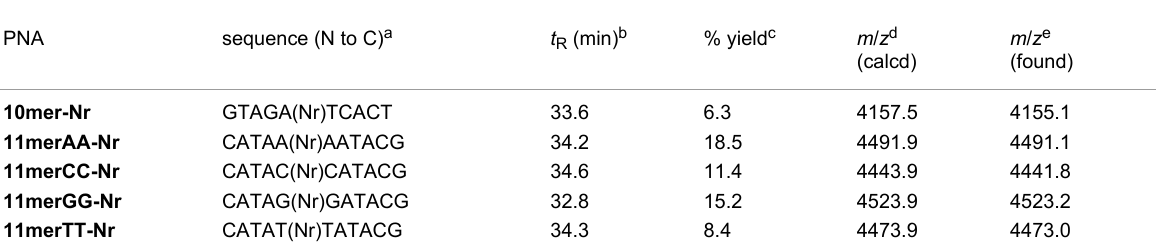
Table 1: Sequence, isolated yield and characterization data of Nile red-labeled acpcPNA.